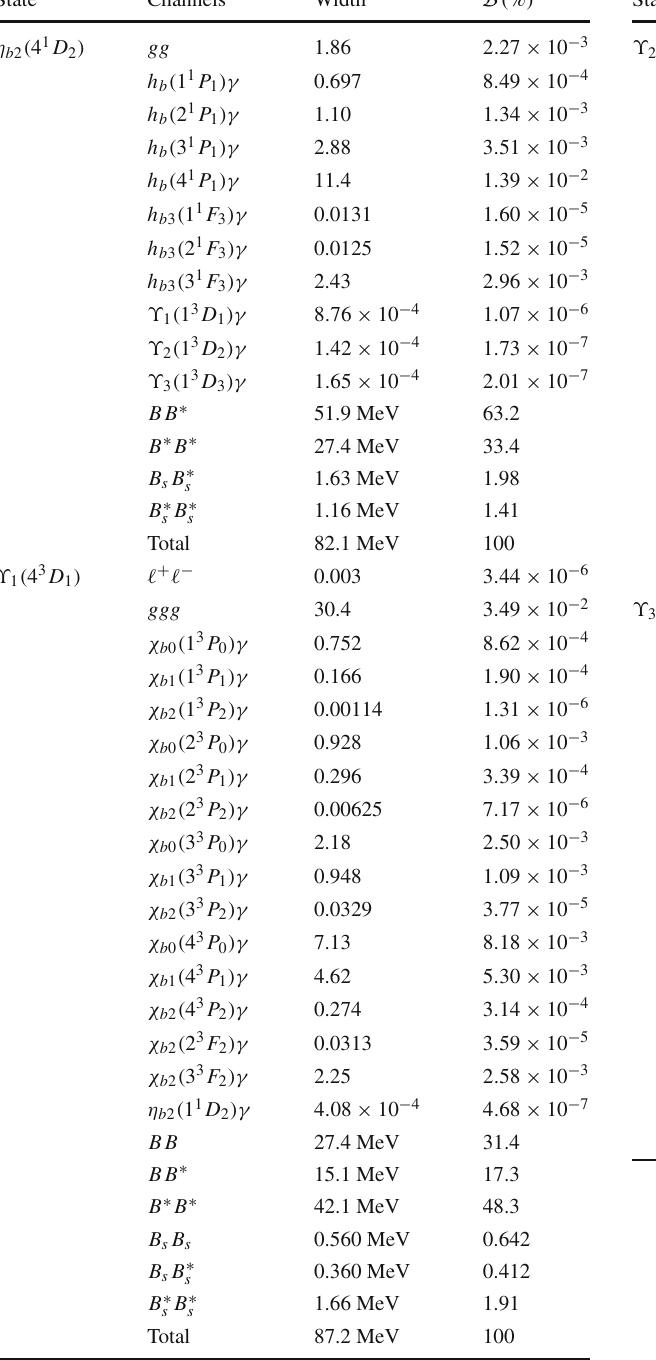
Table30 PartialwidthsandbranchingratiosoftheOZI-allowedstrong decay, annihilation decay, and radiative transition and total widths for 4 3 D 2 and 4 3 D 3 bottomonium states. The width results are in units